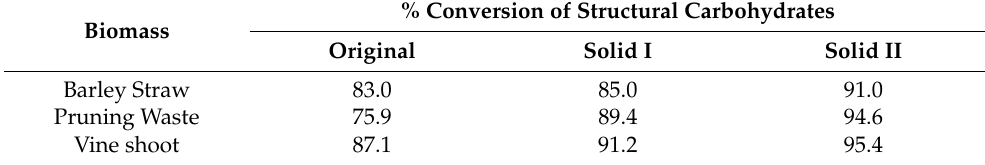
Table 5. Results of hydrolysis conversion for original biomass and fractioned biomass (Solid I and Solid II). The reaction conditions were 140 ◦ C and 5 h, and H 2 SO 4 (0.2 mol/L) was used as a